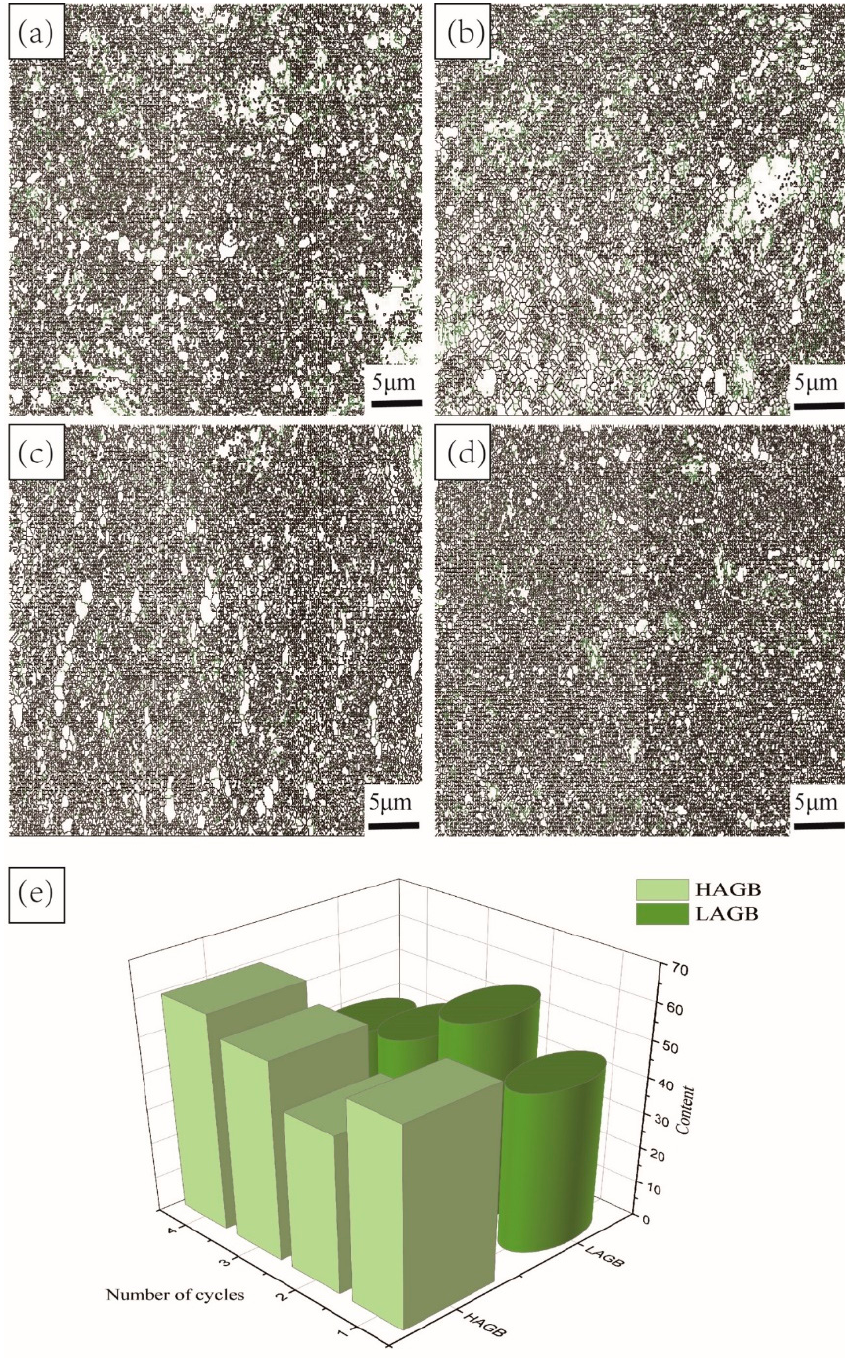
Figure 10. Grain boundary distribution of TC4 alloy after MDIF: ( a ) one cycle; ( b ) two cycles; ( c ) three cycles; ( d ) four cycles; ( e ) variation trend of grain boundary quantity.